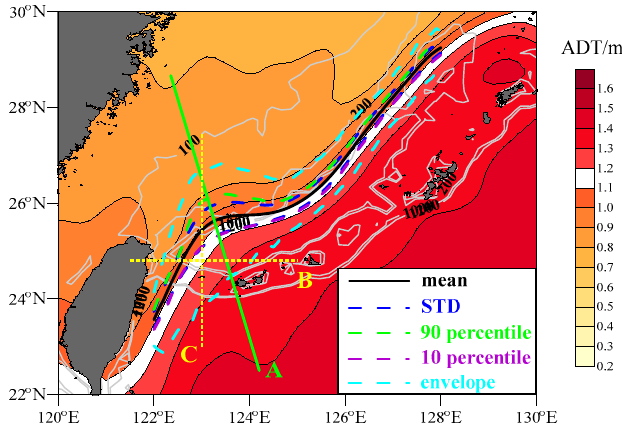
Figure 3. Long-term (1993-2016) mean ADT (color-filled contours) overlaid with Kuroshio mean axis (solid black curve), standard deviation (STD, dashed blue curves), envelopes (dashed cyan curves), 90 percentile (dashed green curve), and 10 percentile (dashed purple curve). Transect A (solid green line perpendicular to the Kuroshio mean axis), B, and C (dotted yellow lines in zonal and meridional direction) are used to analyze the variation of the axis location. Gray contours are isobaths of 100, 200, 1000, and 1200